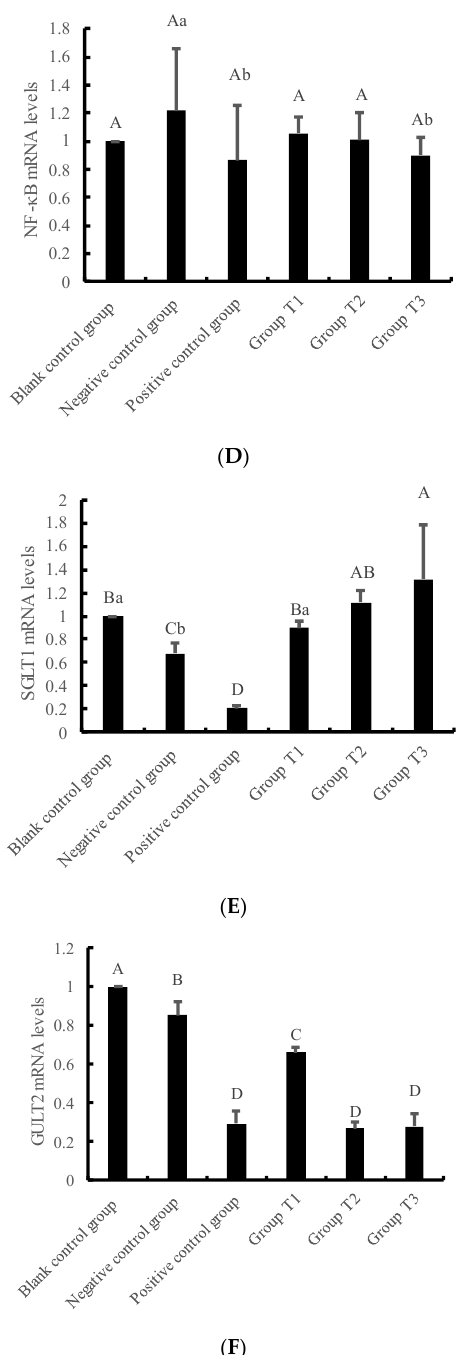
Figure 5. The effects of crude extracts of Dioscorea alata L. on gene expression of IPEC-J2 cells pre-protected against injury caused by H 2 O 2 . The preprotective effect of Dioscorea alata L. was mainly explored by the expression levels of the following genes: ( A ) SOD1, ( B ) SOD2, ( C ) GSH-PX, ( D ) NF- κB, ( E ) SGLT1, ( F ) GULT2. Note: Compared with the blank control group, the difference was significant for different lowercase letters ( p < 0.05), the difference was extremely significant for different